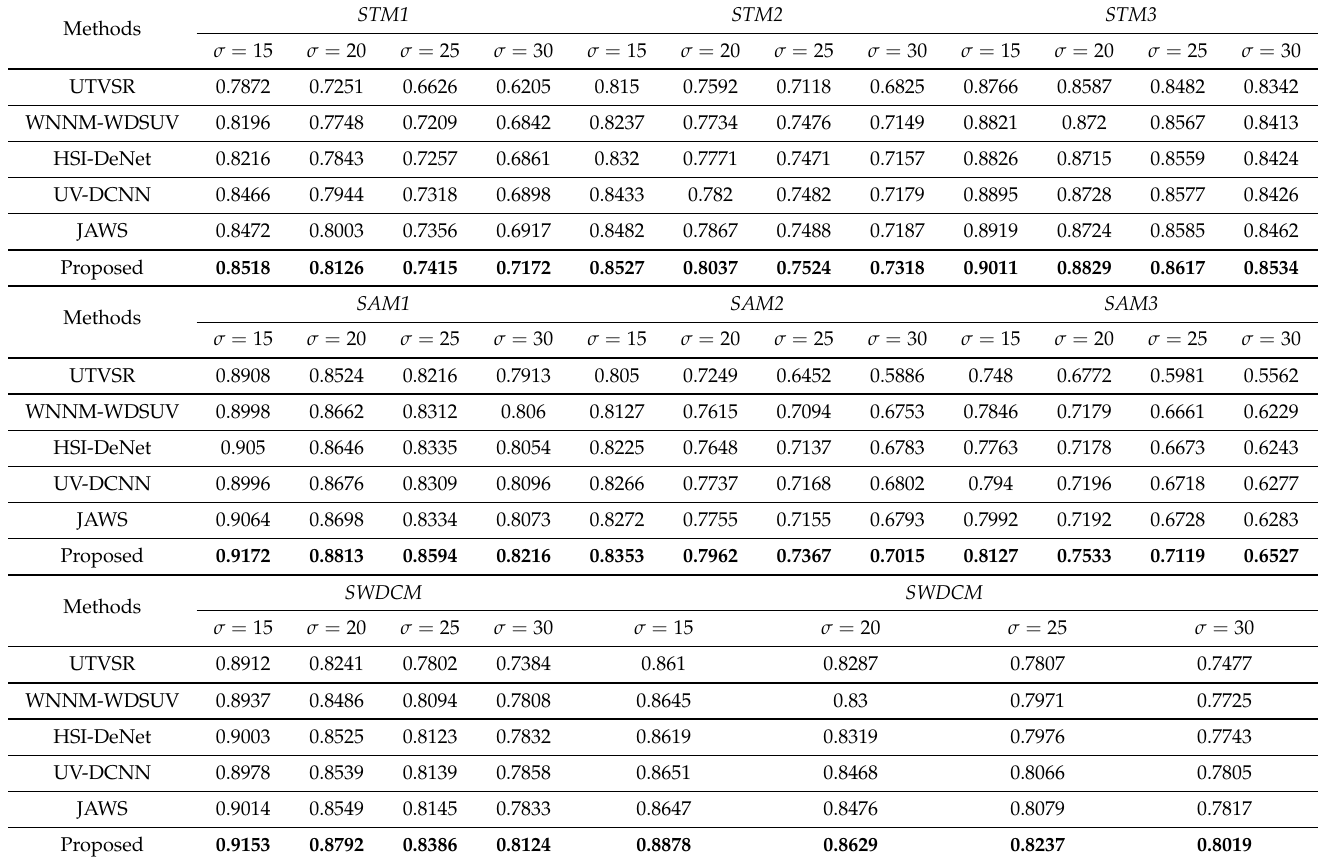
Table 2. Quantitative MSSIM comparisons of the state-of-the-arts on the synthetic optical RSIs shown in Figure